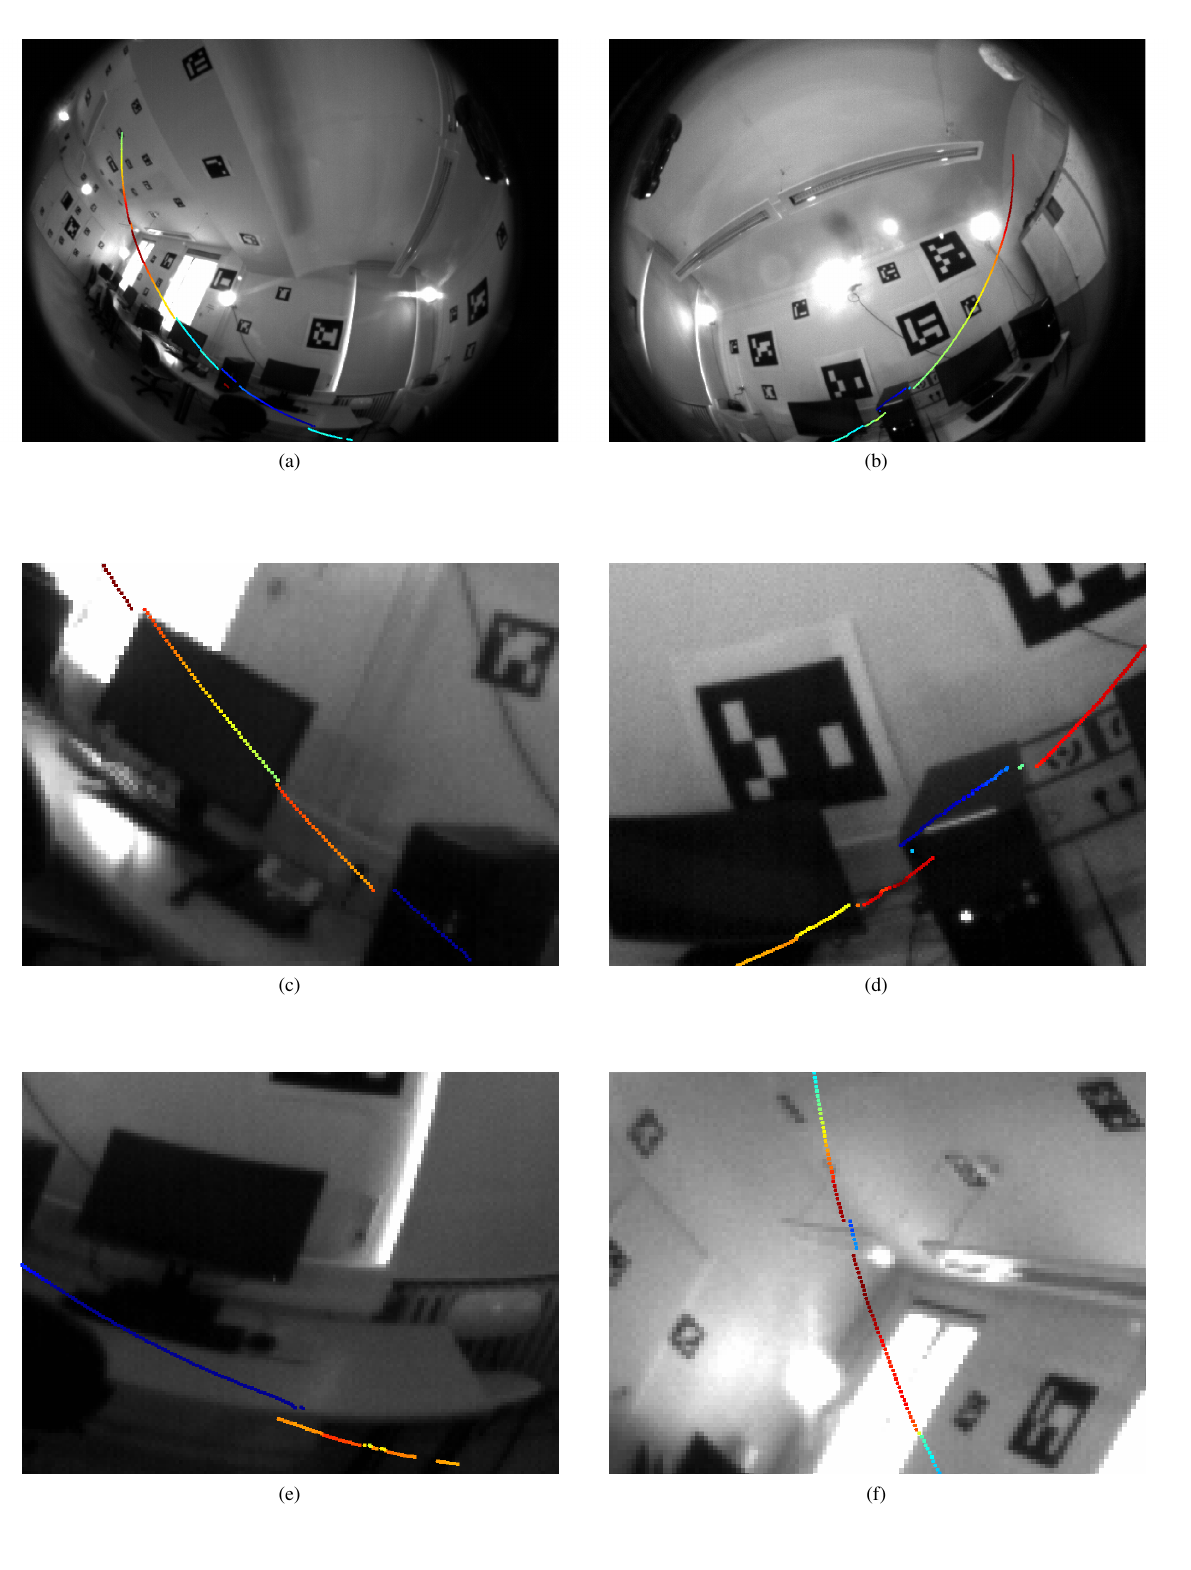
Figure 5: Backprojected laserscanner observation. (a) Image taken by left camera, (b) Image taken by right camera, (c) Detailed view of the left image, (d) Detailed view of the right image, (e) Example of the parallax at close range, (f) Example of the parallax at far range. The color represents the range measured by the laserscanner (blue: close range, red: far range). For convenience, the color spectrum for the cases (c) - (f) is adjusted to the individual image